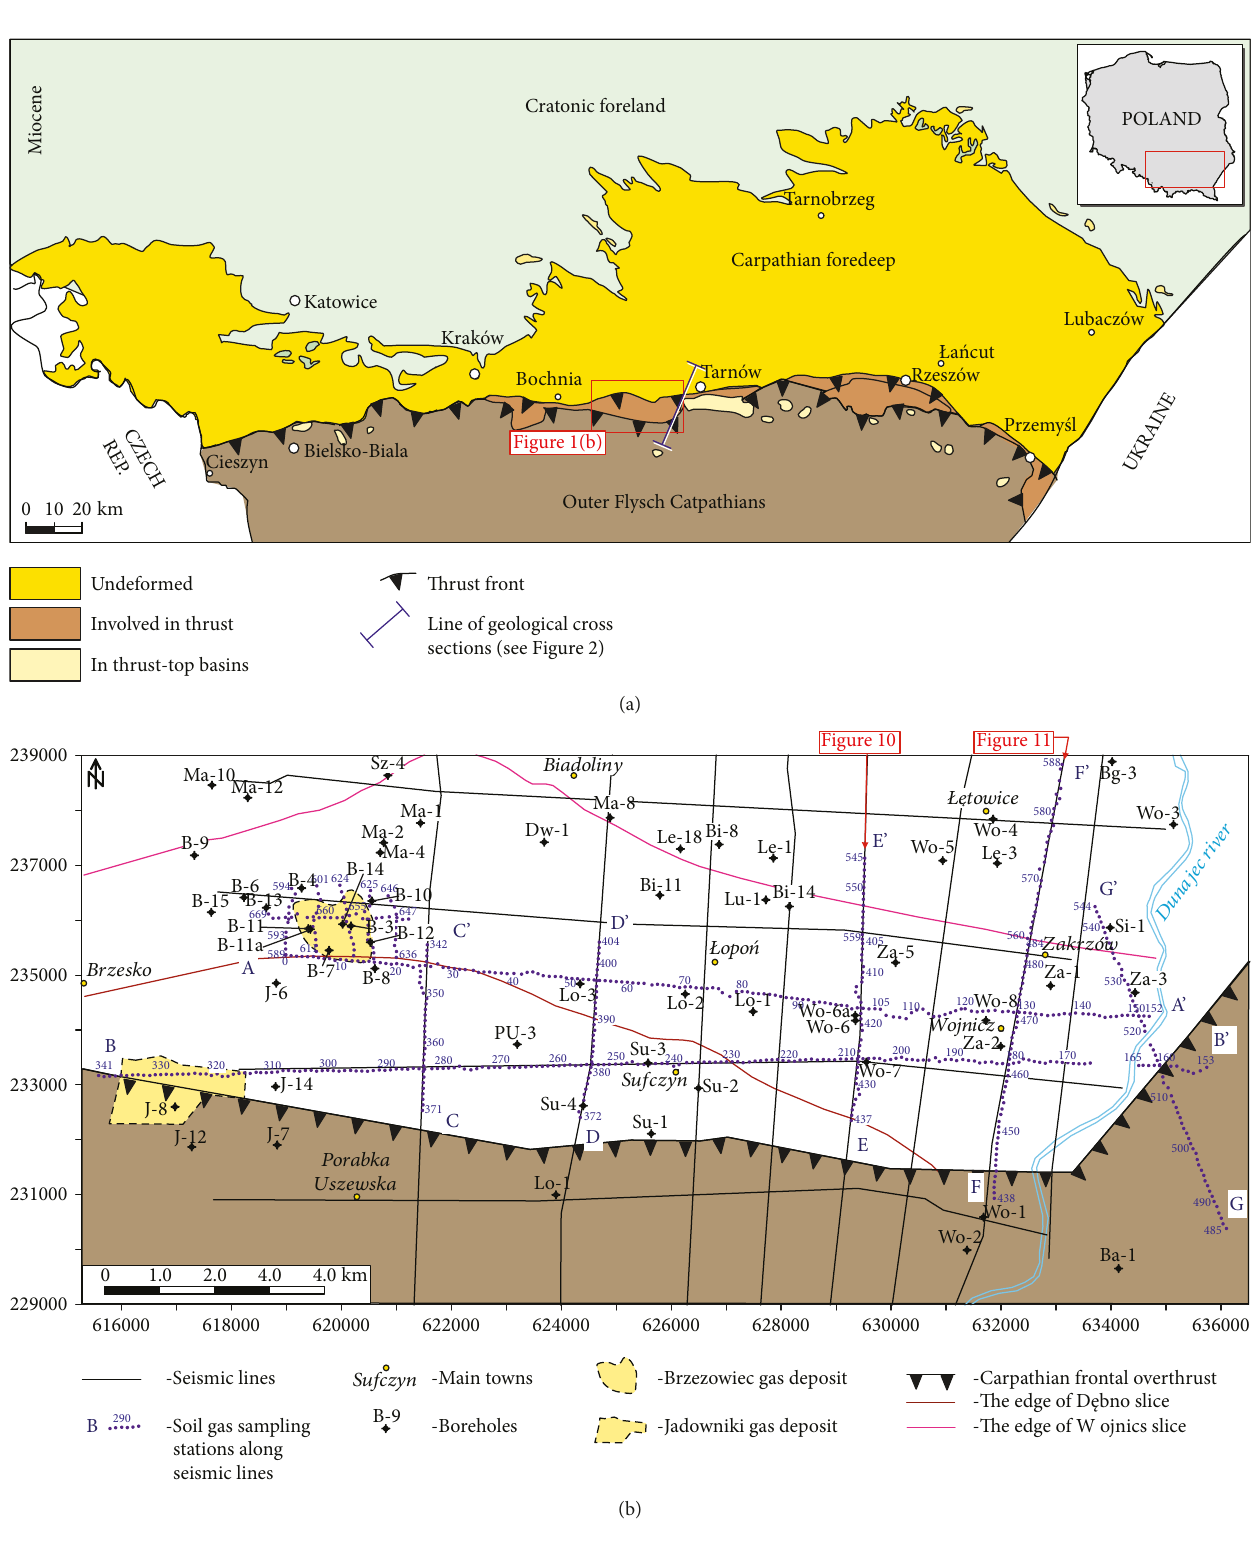
Figure 1: Location of the study area (rectangle) at the background of (a) a simpli fi ed geological map of the Outer Carpathians and their foreland (after [13], modi fi ed) and (b) the detailed location of soil gas sampling stations and boreholes as well as the main tectonic